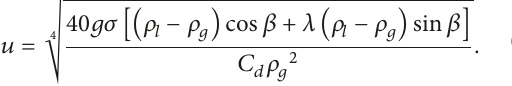
Figure 2: Nonlinear fitting